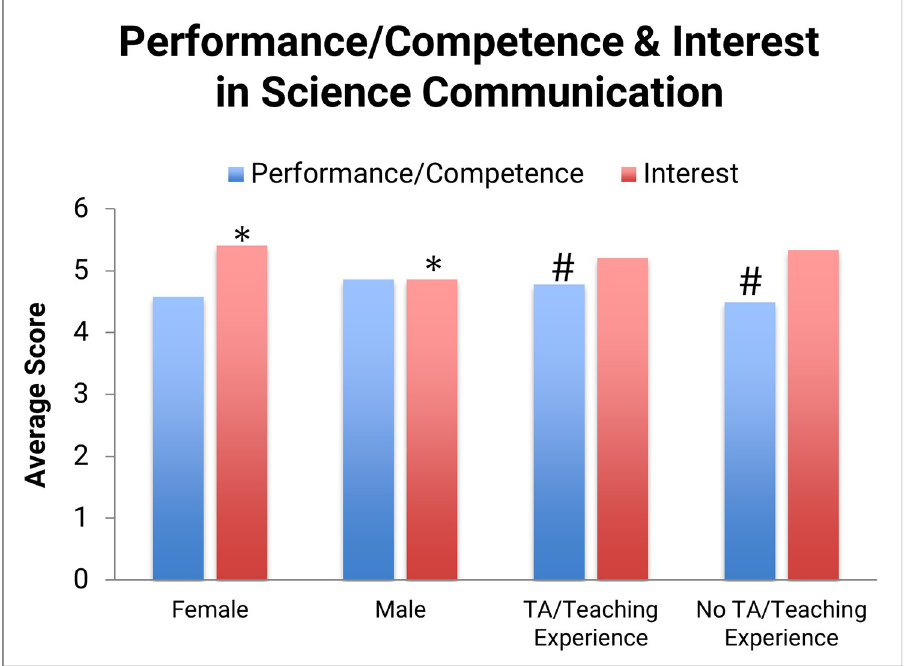
Fig 6. Participant performance/competence and interest and in science communication. Further statistical tests were done to examine relationships between interest and competence/performance in science communication, gender, and previous teaching experience. Bars with asterisks and hashtags indicate a statistically significant difference between two groups, gender and teaching experience, respectively. A corresponding data chart is found in S1 File (S3 Table).